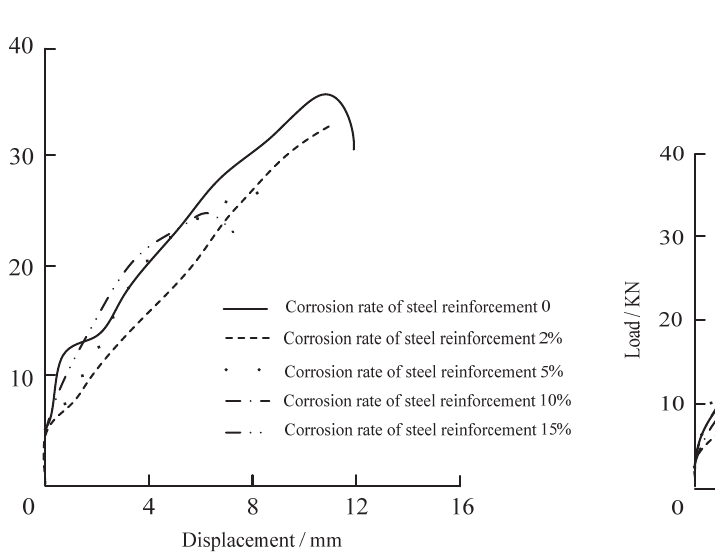
Figure 9: Curves of load-displacement (axial compression ratio 0.4).